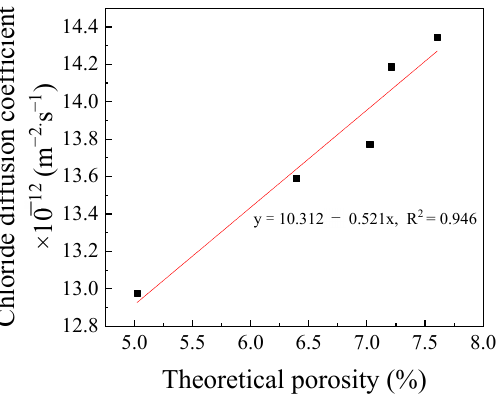
Figure 12. The relationship between chloride diffusion coefficient and theoretical porosity.